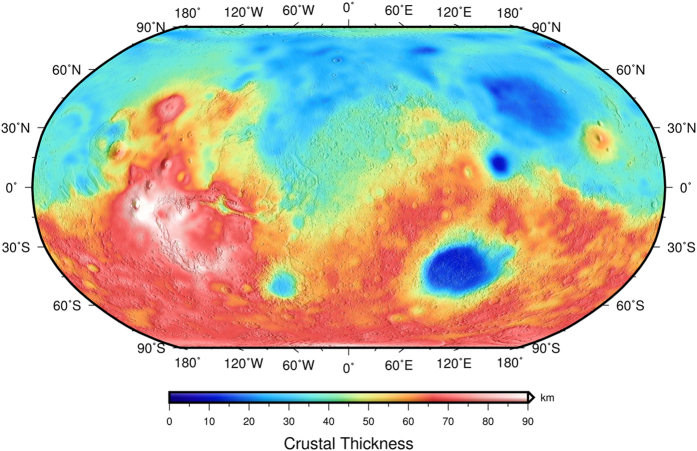
Crustal thickness model for Mars assuming a mean crustal thickness of 50 km, and crust and mantle densities of, respectively, 2900 and 3500 kg m−3, shown over a shaded relief map of Mars Orbiter Laser Altimeter (MOLA) topography64 for context.